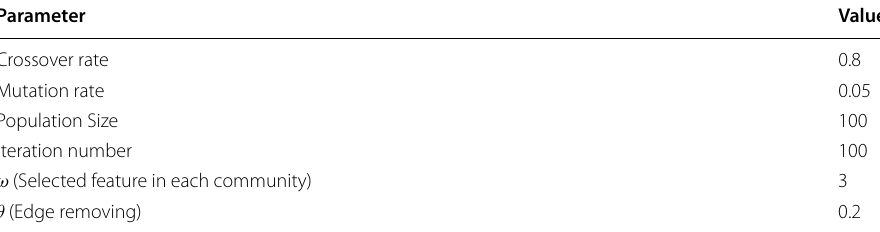
Table 2 User-specified parameters of the GA-based